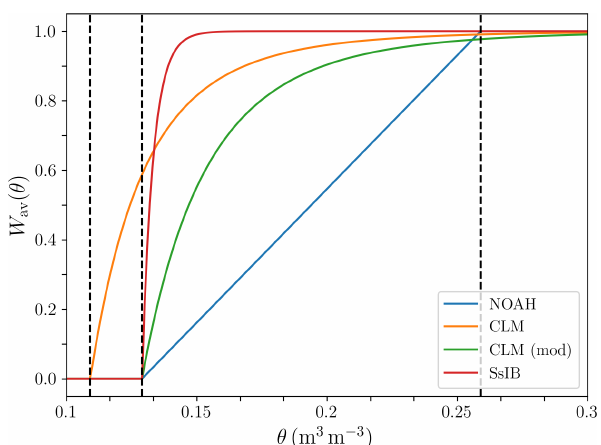
Figure 4. Factor limiting plant water uptake as a function of volu- metric soil water content. The dashed vertical lines represent, from left to right, the volumetric soil water content at a wilting matric potential of − 150m, at a wilting matric potential of − 45m, and at field